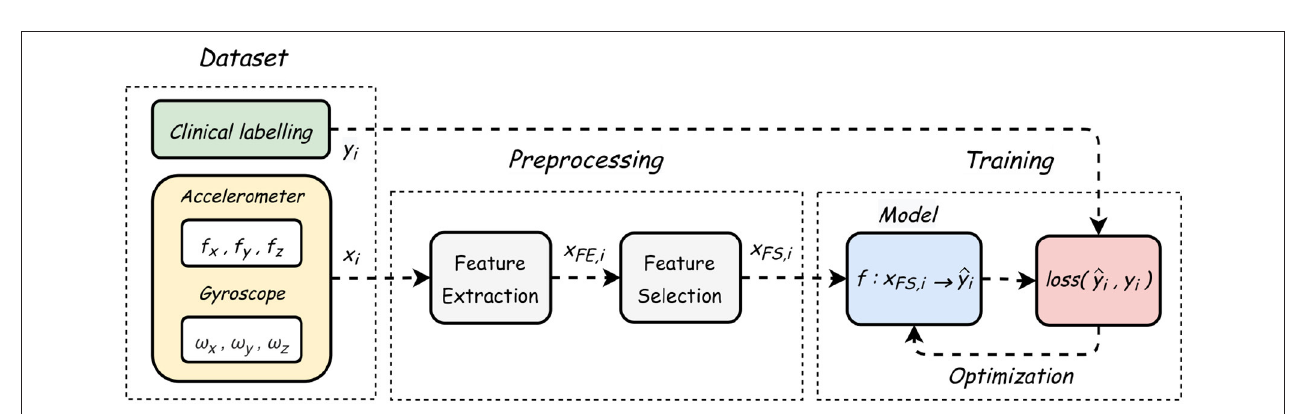
FIGURE 2 | Phone placed on back of the dog using harness; photos from different sides.